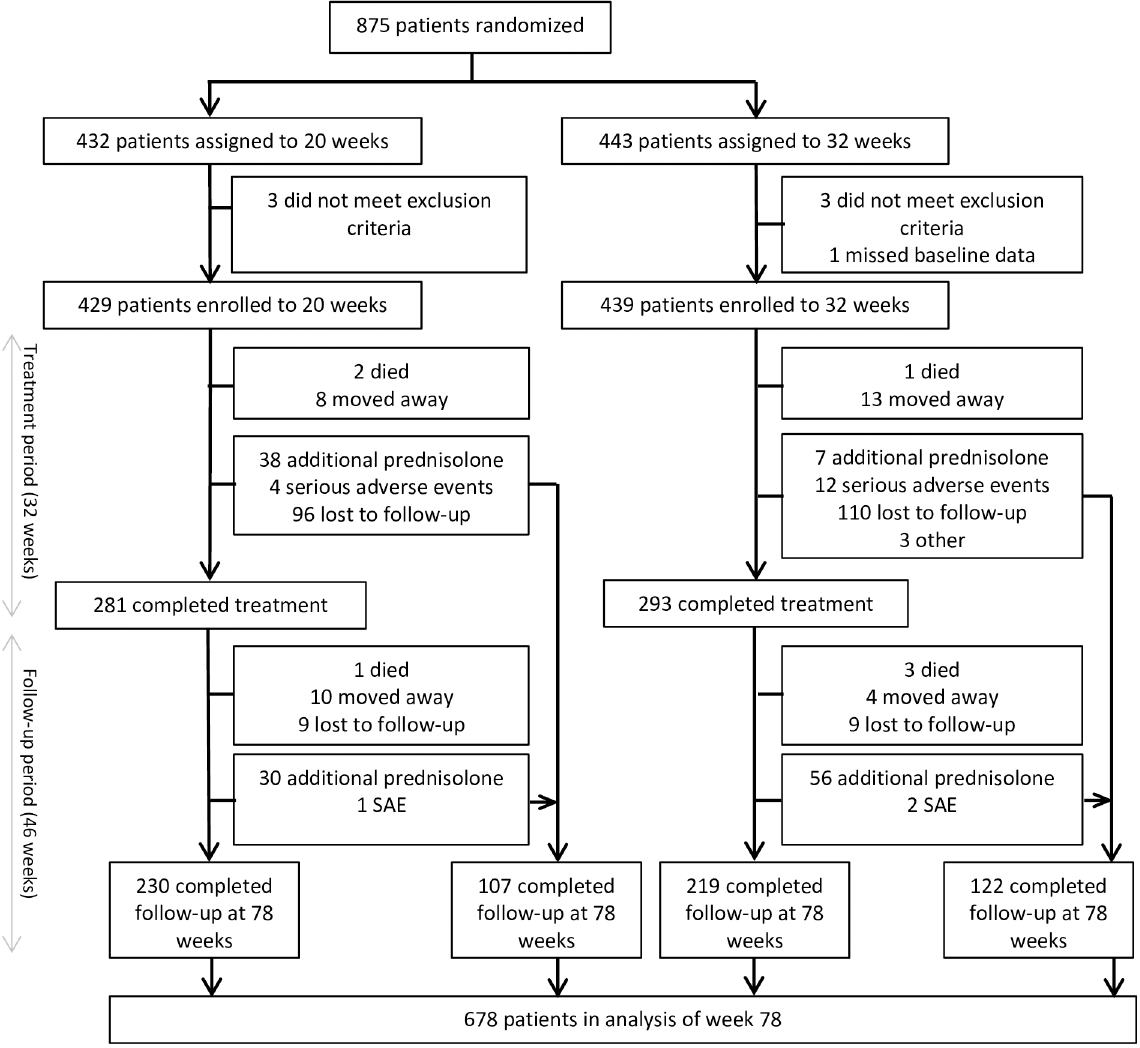
Fig 1. Flow diagram of number of patients enrolled, randomized, treated and followed-up.